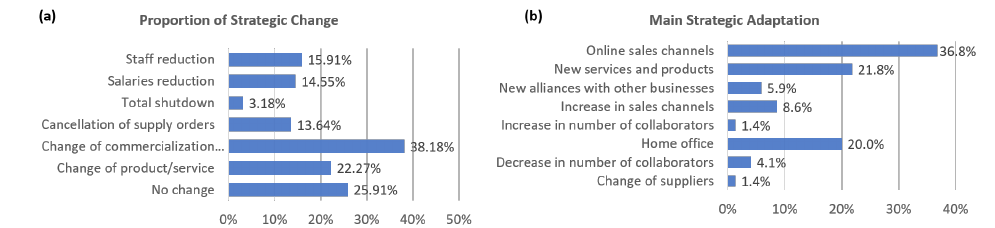
Figure 3. Sample proportion of ( a ) strategic changes, and ( b ) strategic